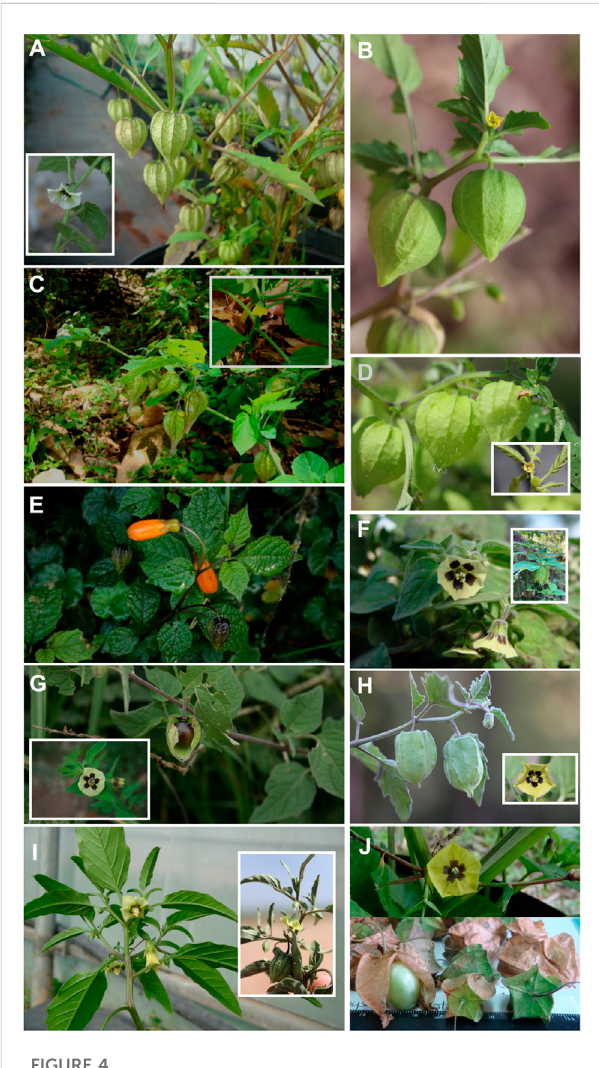
Details of fl owers and fruits of Physalis spp. (A) P. acutifolia , (B) P. angulata , (C) P. aggregata , (D) P. ampla , (E) P. campanula , (F)